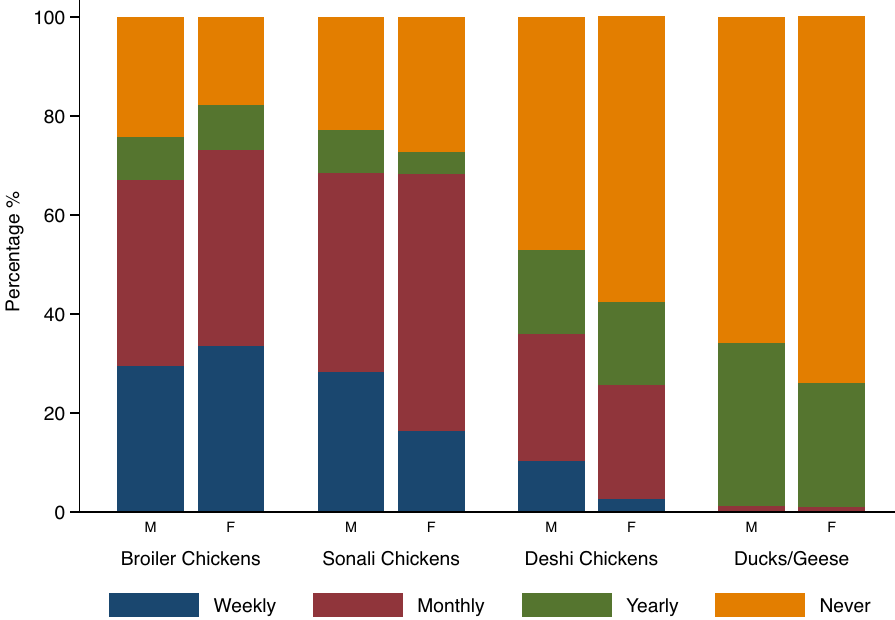
Figure 2. Poultry purchasing practices among those who have visited a live poultry market in the past year, by sex, Dhaka City Corporation, Bangladesh. Purchasing practices varied by poultry type, broiler and Sonali chickens were predominantly purchased on a weekly or monthly basis while ducks and geese were purchased only annually. Purchasing practices were similar between males and females. The denominator is the weighted number of respondents reporting visiting a market in the past year, by sex.